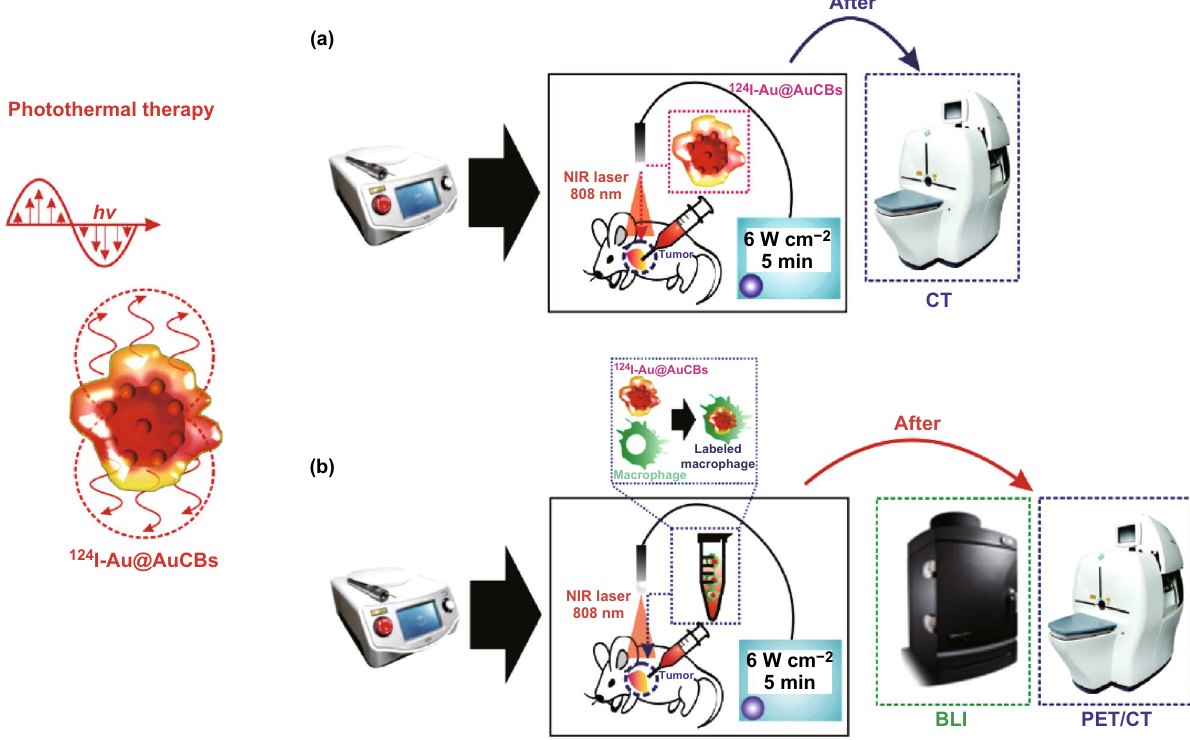
Fig. 1 A schematic representation of the evaluation of a in vivo photothermal conversion effects of 124 I‑Au@AuCBs and b in vivo photothermal therapy using 124 I‑Au@AuCB‑labeled macrophages in a colon cancer model, followed by positron emission tomographic imaging of 124 I‑Au@ AuCB‑labeled macrophage distribution in tumor